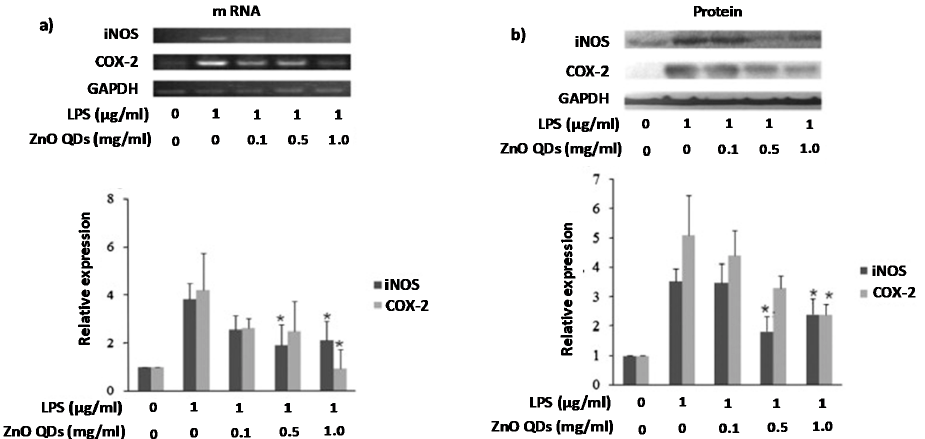
Figure 11. ( a ) Determination of iNOS and COX-2 mRNA levels by RT-PCR; ( b ) Determination of iNOS and COX-2 protein levels by Western blot (mean ± SD of n = 3 and * p < 0.05 versus LPS alone). Reproduced with permission from [119]. Elsevier, 2015.